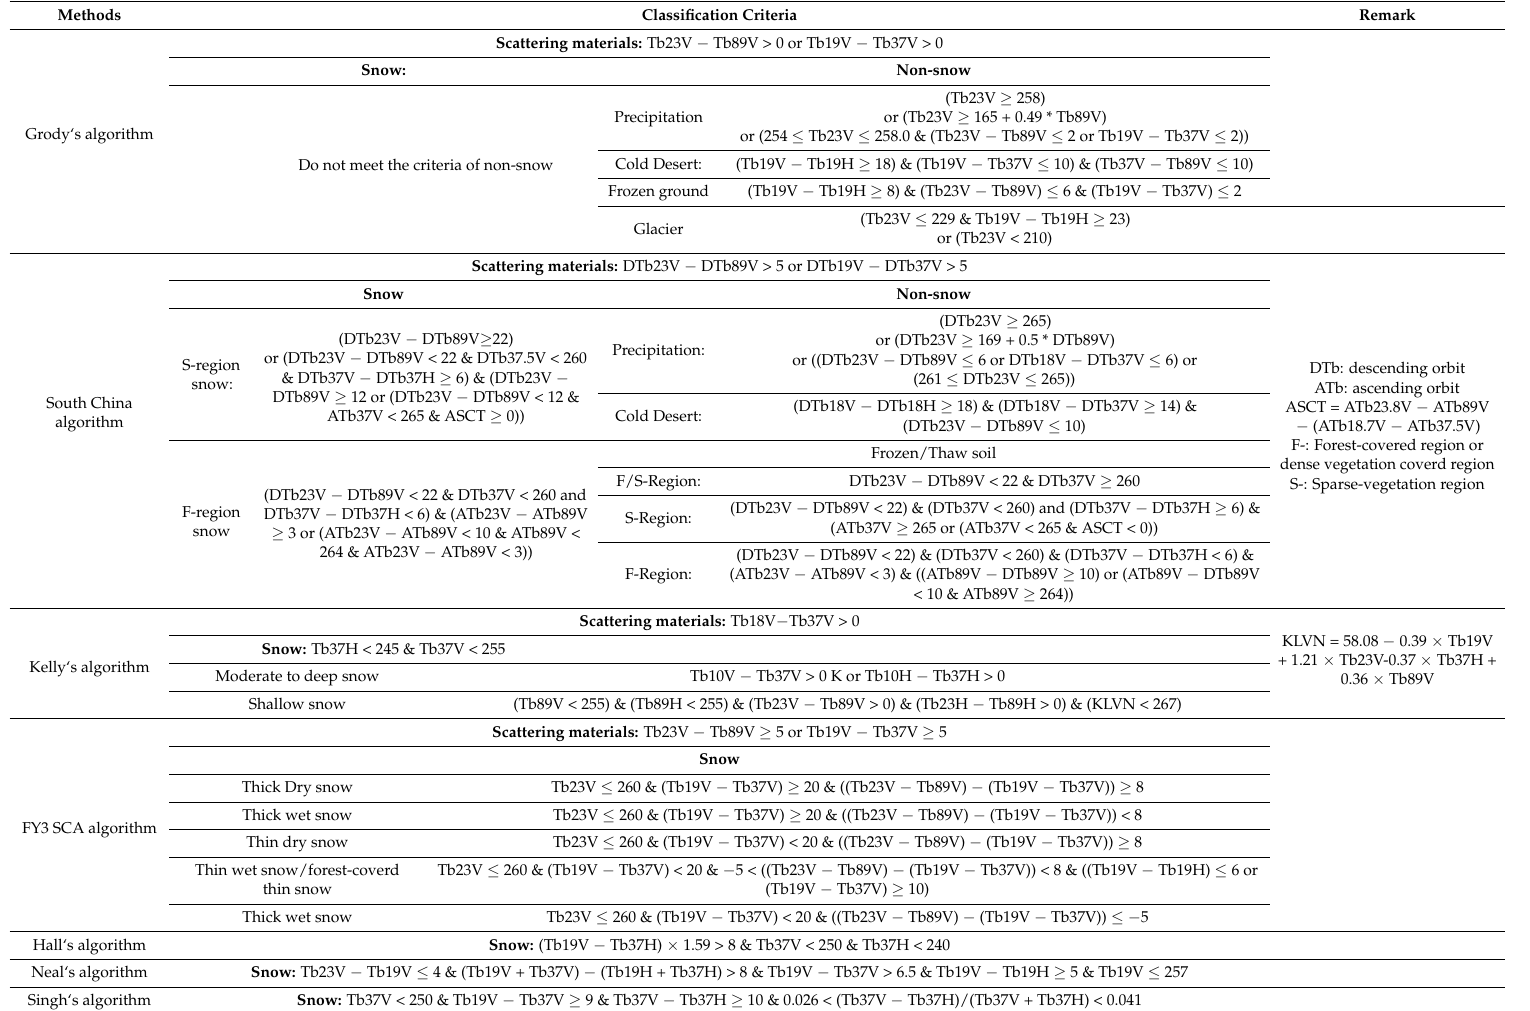
Table 1. Classification criteria of passive microwave (PMW) snow cover area (SCA) mapping